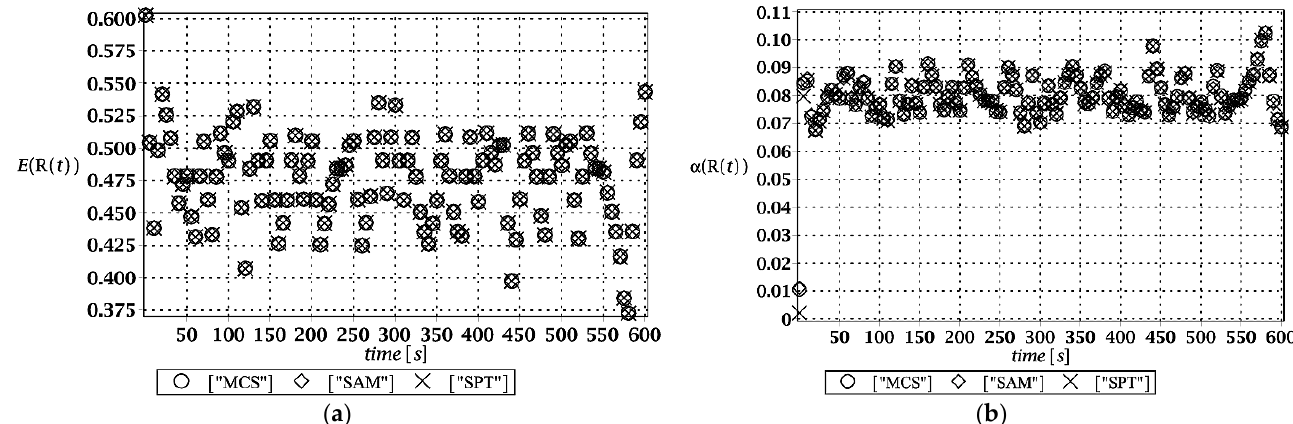
Figure 11. ( a ) The expectation of bearing capacity at the ridge of frame for uncertain snow load; ( b ) its CoV.